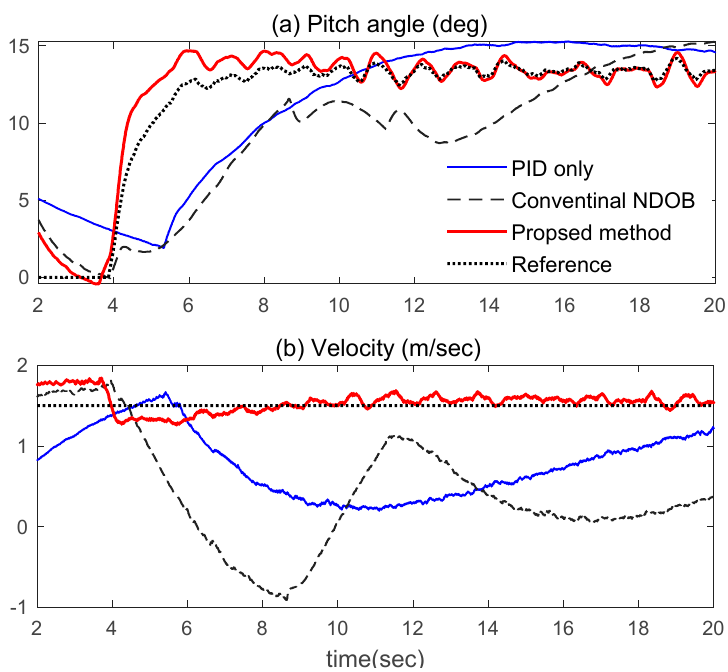
Figure 8. Climbing a ramp with an unknown slope of 10 degrees. The pitch references for PID and conventional NDOB were zero.